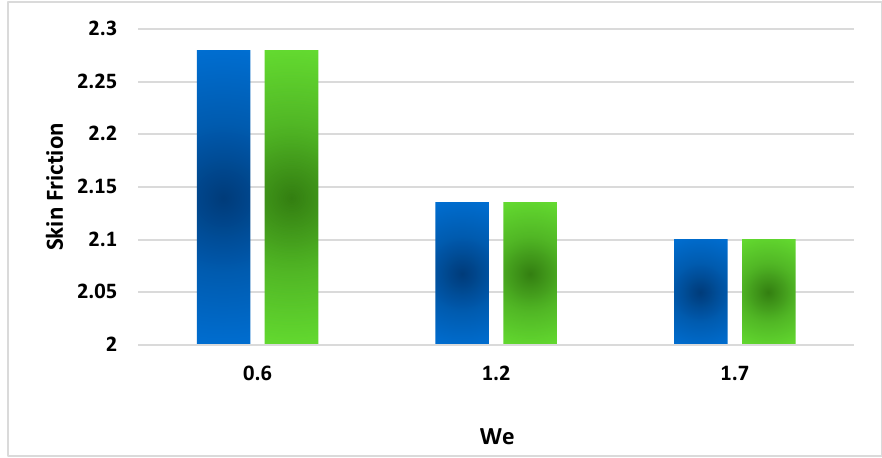
Figure 14. Revealing the consequences of We with the related skin friction coefficient.